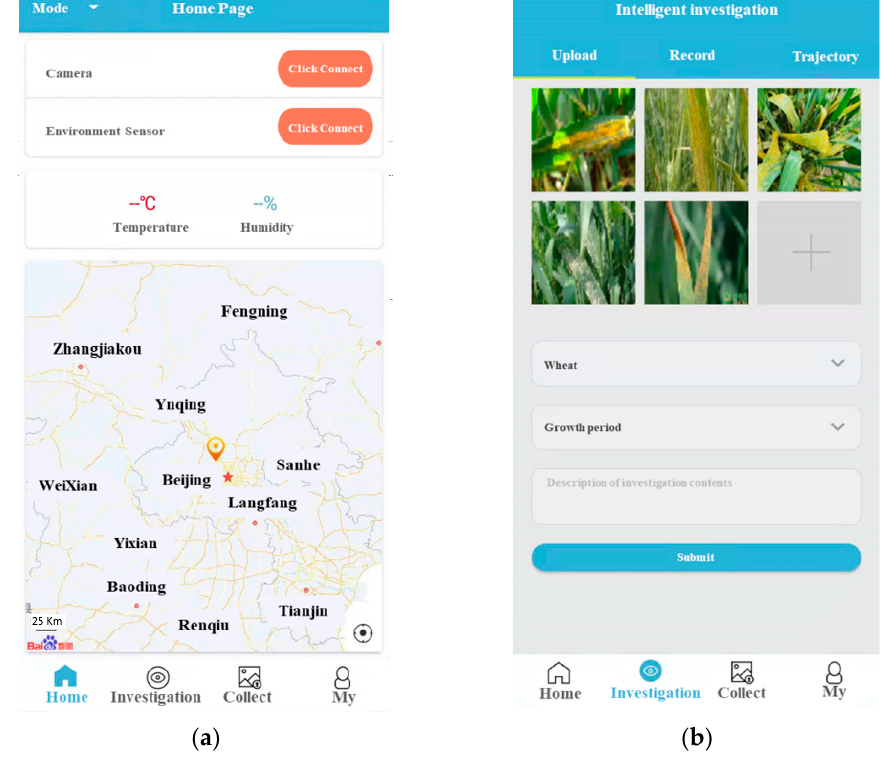
Figure 4. Mobile terminal interface. ( a ) The main interface displays geographical location and meteorological data. ( b ) Image upload and selection of crops and growth period.